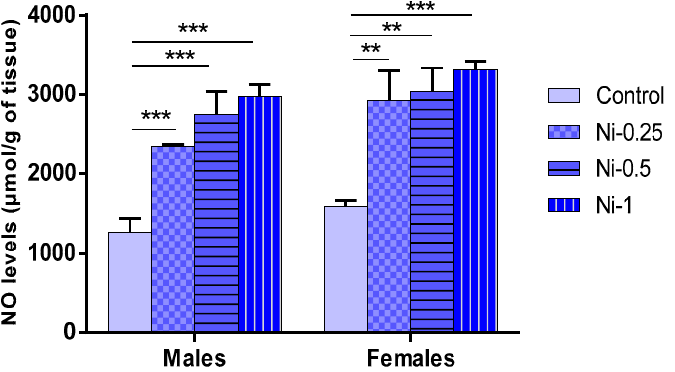
Figure 7. Determination of the nitric oxide (NO) levels in hippocampus, expressed in µ mol/g of tissue in male and female rats after 8 weeks of treatment with 0.9% of NaCl (Control), 0.25 mg/kg (Ni-0.25), 0.5 mg/kg (Ni-0.5), and 1 mg/Kg (Ni-1) of Ni. Results are represented as mean ± SEM. The significance level is 0.05. ** p < 0.01, *** p < 0.001.